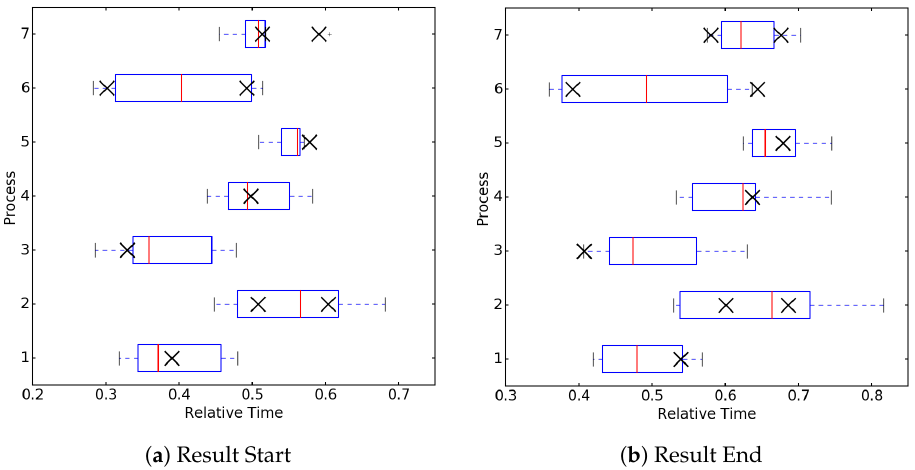
Figure 6. Overall estimate of grabbing start ( a ) and end ( b ) point for picking dataset. Cases 2, 6, and 7 contain two activities and therefore also two crosses in the